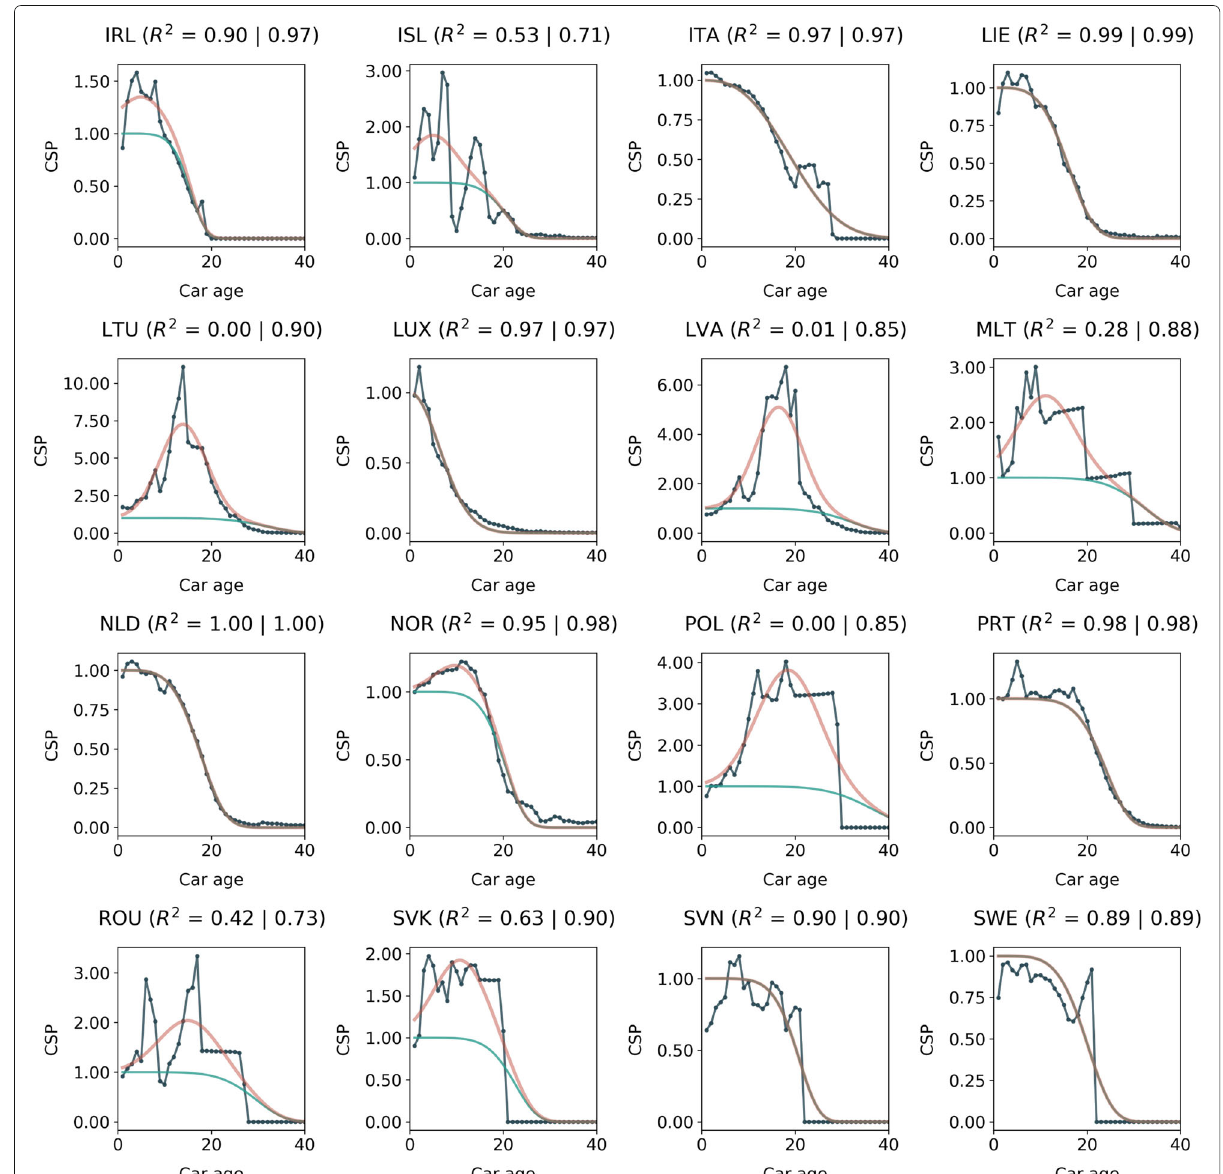
Fig. 3 Cumulative survival probability (CSP) data for European countries (2/2). A Weibull curve (turquoise) and the sum of a Weibull and a Gaussian curve (red) are fitted to the data (dark